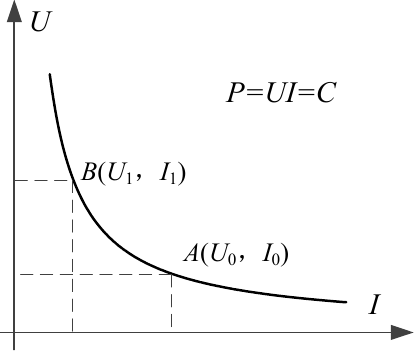
Figure 3. Constant power load characteristic curve.